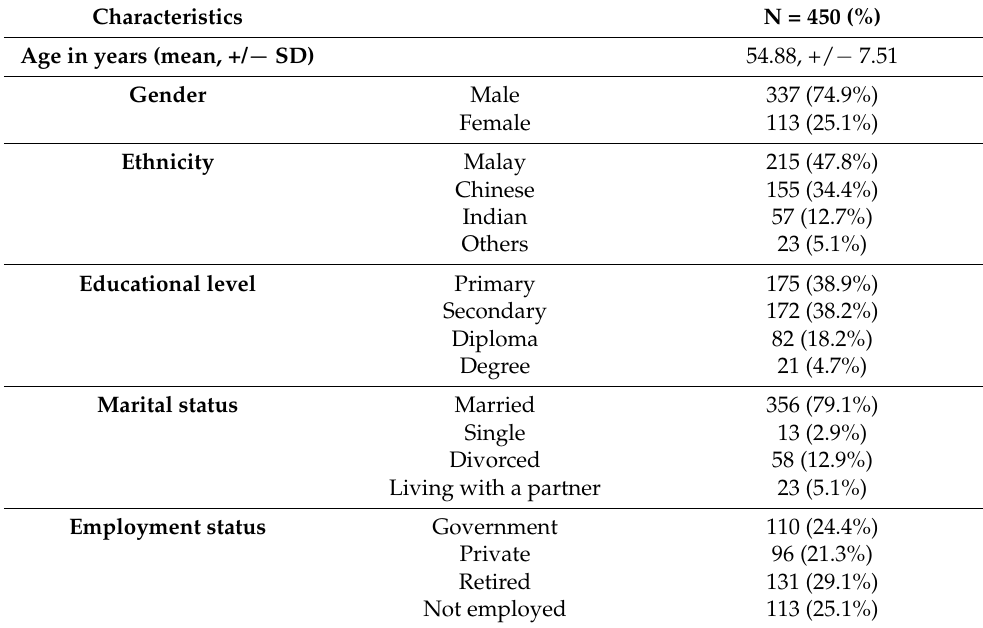
Table 2. Demographics characteristics of the patients.